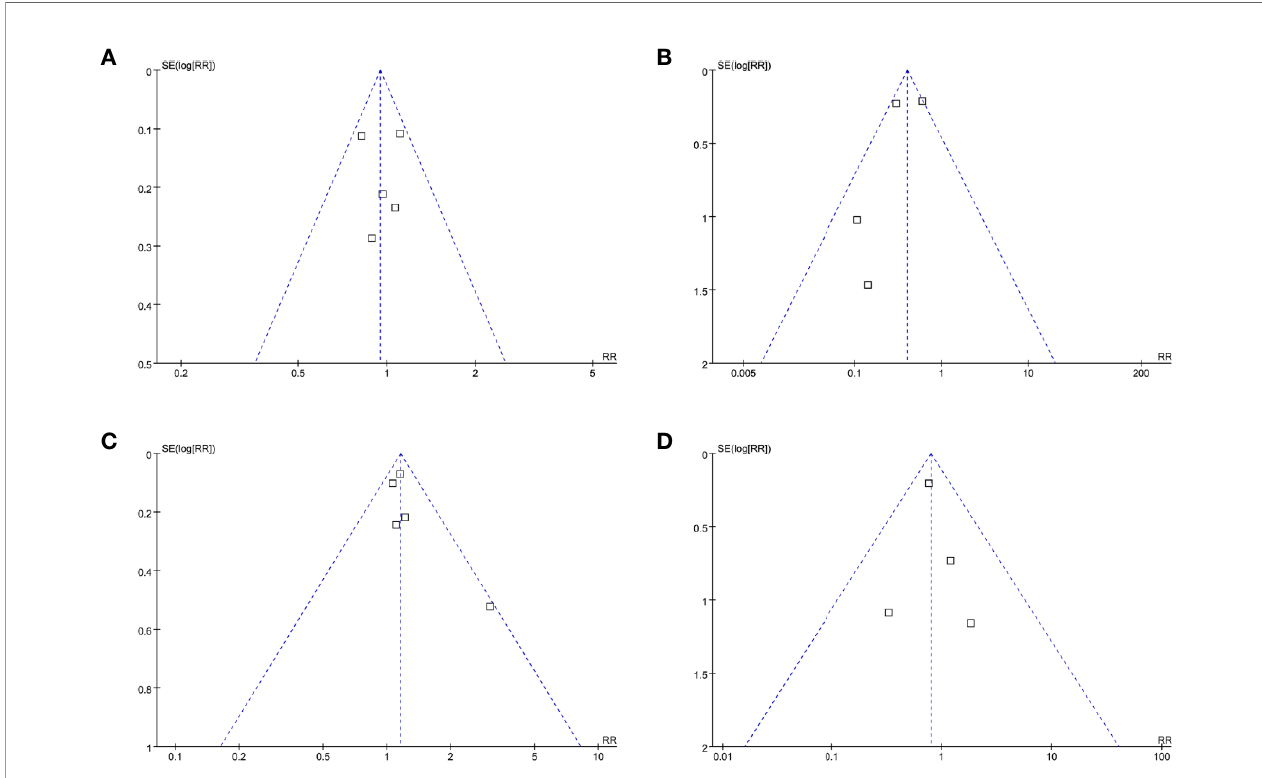
FIGURE 5 | Funnel plots for the meta-analyses. (A) , response rate for meta-analysis comparing topical timolol and oral propranolol for treating IH; (B) , safety outcome for the meta-analysis comparing topical timolol and oral propranolol for treating IH; (C) , response rate for meta-analysis comparing combined therapy and oral propranolol for treating IH; (D) , safety outcome for the meta-analysis comparing combined therapy and oral propranolol for treating